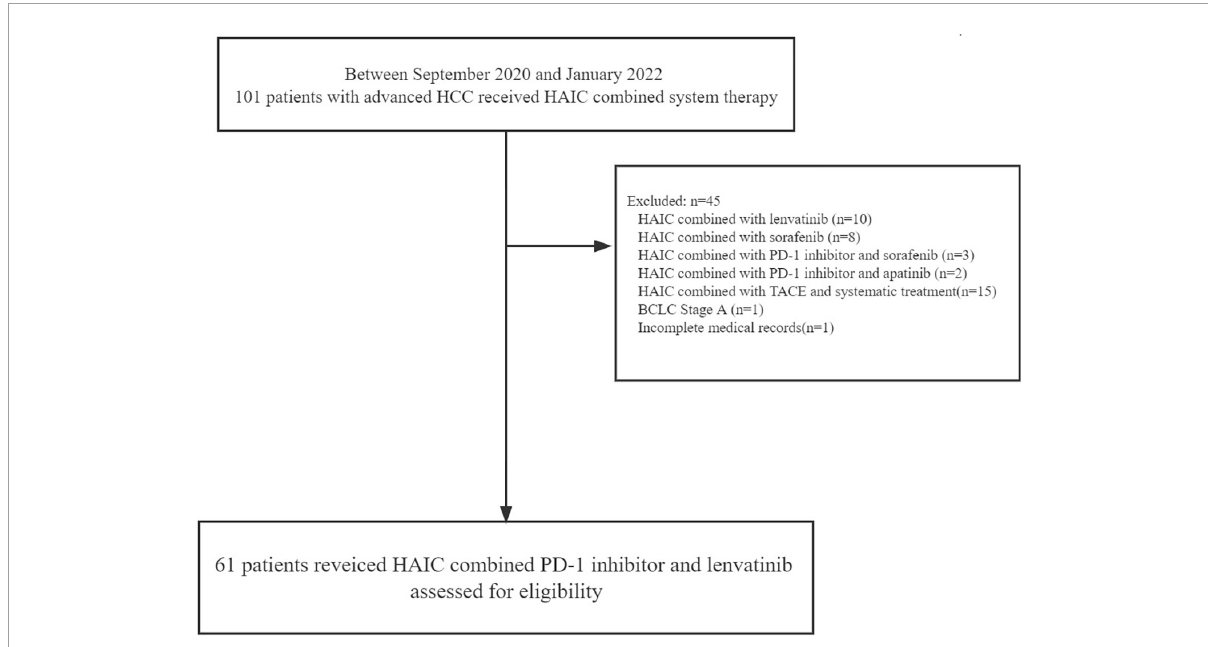
FIGURE1 Patient selection flow. HCC, hepatocellular carcinoma; HAIC, hepatic arterial infusion chemotherapy; PD-1, programmed cell death protein-1; TACE, transarterial chemoembolization; BCLC, Barcelona Clinic Liver Cancer.